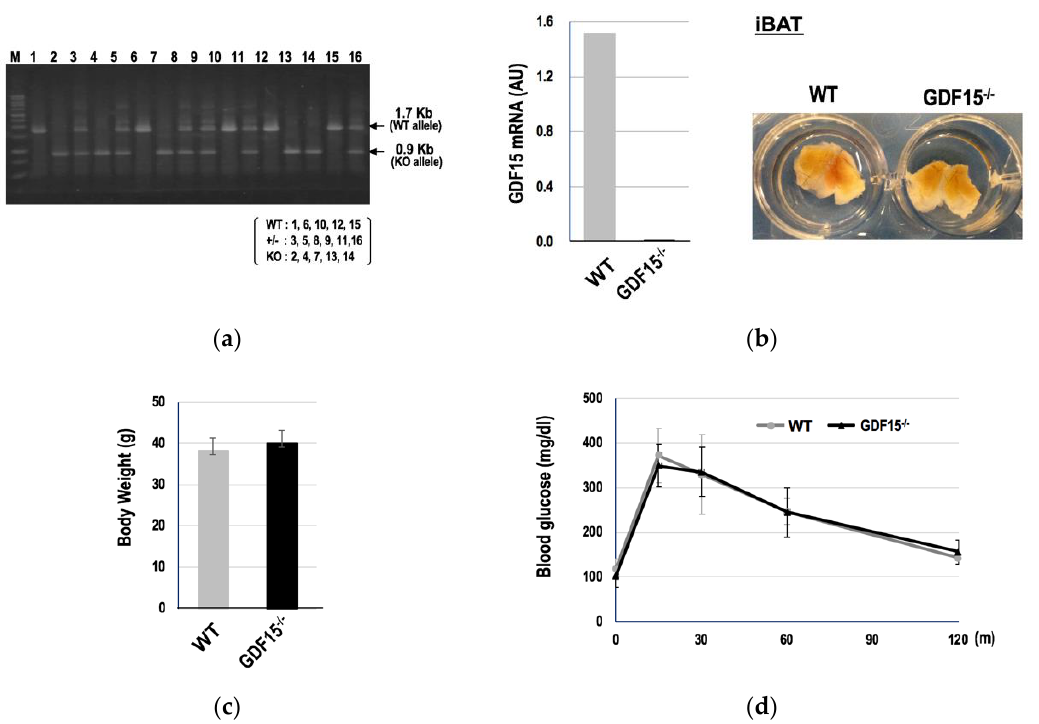
Figure 3. GDF15 - /- mice have normal brown adipose tissue (BAT) and are metabolically healthy. Results of the PCR-based genotyping of the offspring ( a ). GDF15 mRNA expressions ( b , left) and macroscopic features ( b , right) of the iBAT of wild-type (WT) or GDF15 -/- mice are shown. There were no significant differences in body weight ( c ) or glucose tolerance, which was evaluated by an oral glucose tolerance test (OGTT) ( d ), between WT and GDF15 - / - mice (WT: n = 8; GDF15 - / - : n = 15) after an 8-week high-fat diet. Data are shown as mean ± SD.